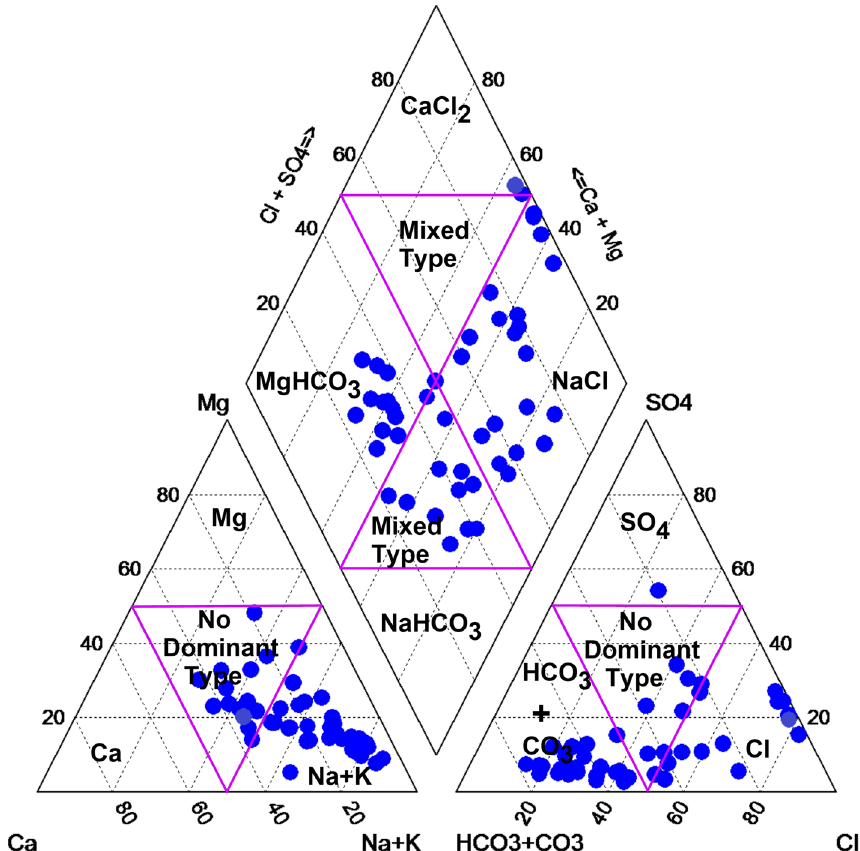
Fig. 4 Piper trilinear diagram for the groundwater samples